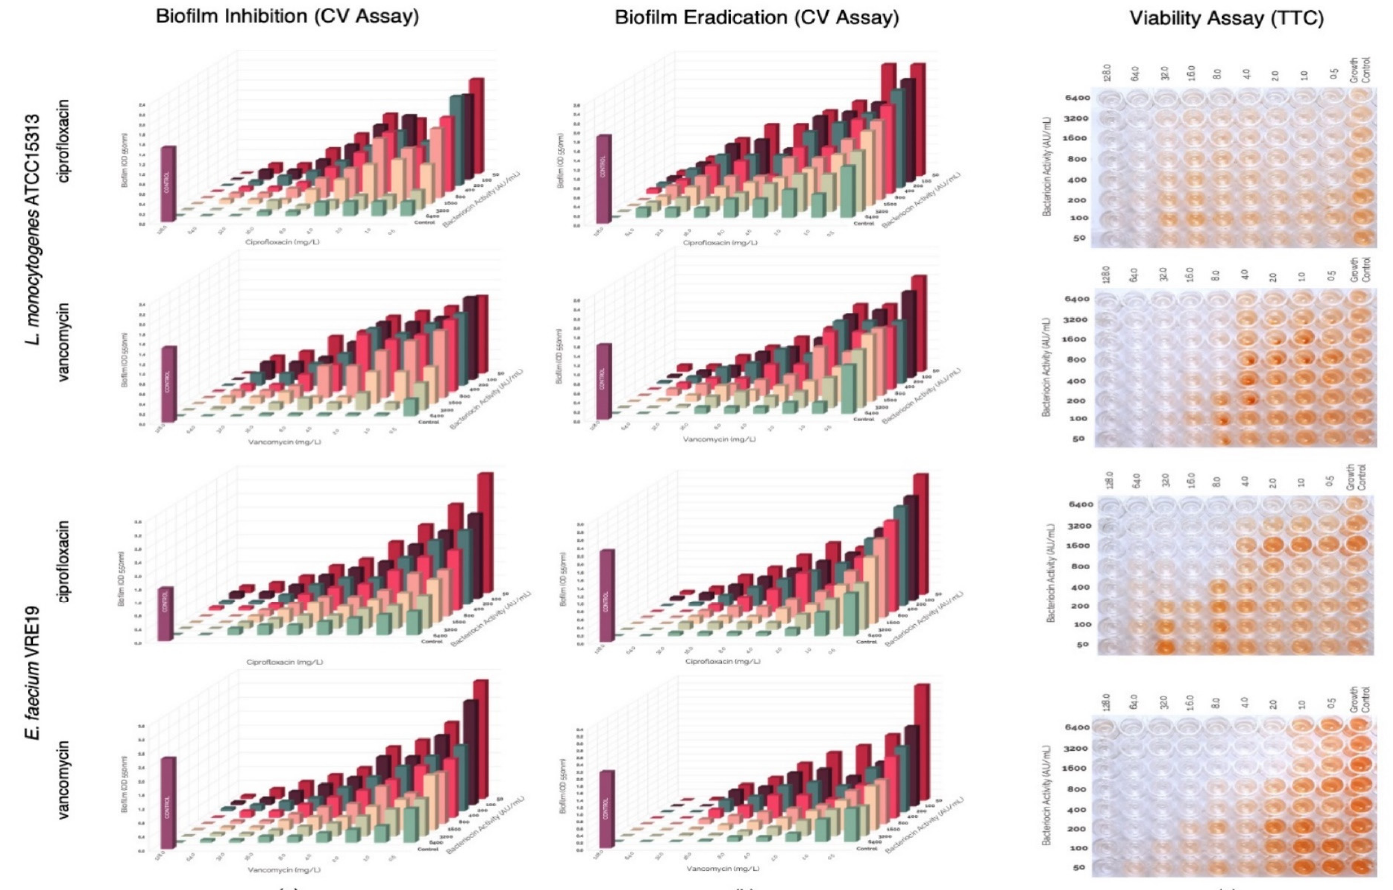
Figure 4. Evaluation of synergy between semi-purified bacteriocin ST7119ea and antibiotics (ciprofloxacin or vancomycin) on the ( a ) biofilm formation and ( b ) biofilm eradication of Listeria monocytogenes ATCC15313 and Enterococcus faecium VRE19 as demonstrated on the topographic analysis biofilms by crystal violet assay; and ( c ) confirmation of cell viability were carried out using TTC assay.